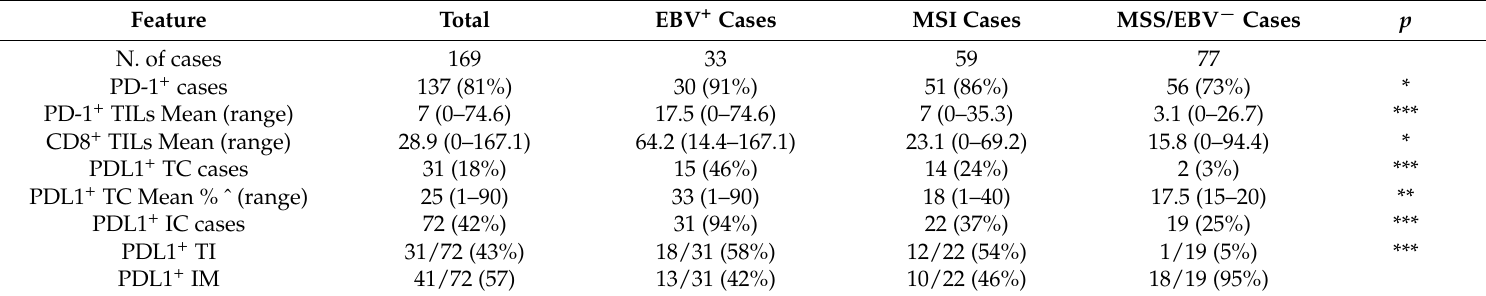
Table 2. Immunophenotype of TILs and PD-L1 expression on tumor and immune